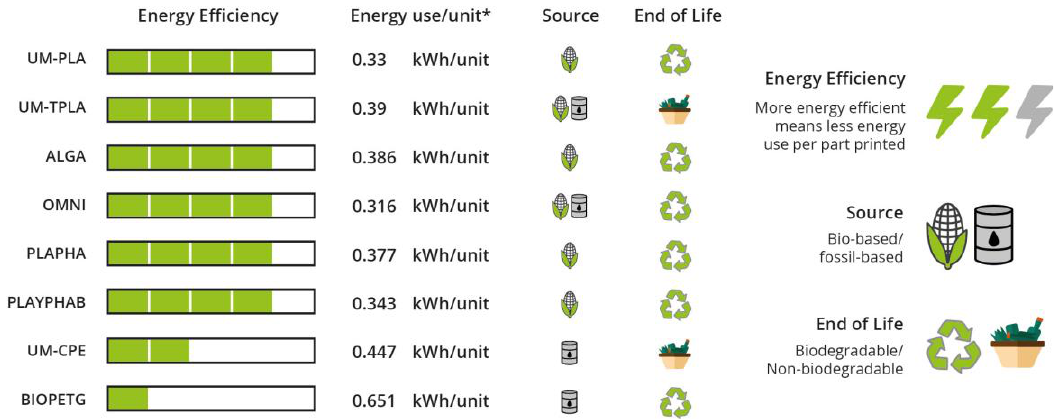
Figure 11. Material Guide for Green 3D printing: energy consumption and some material characteris- tics. Adapted from “3D Printing with Bioplastics”, 2020 [61]. * One unit refers to this reference part used for universal comparisons.